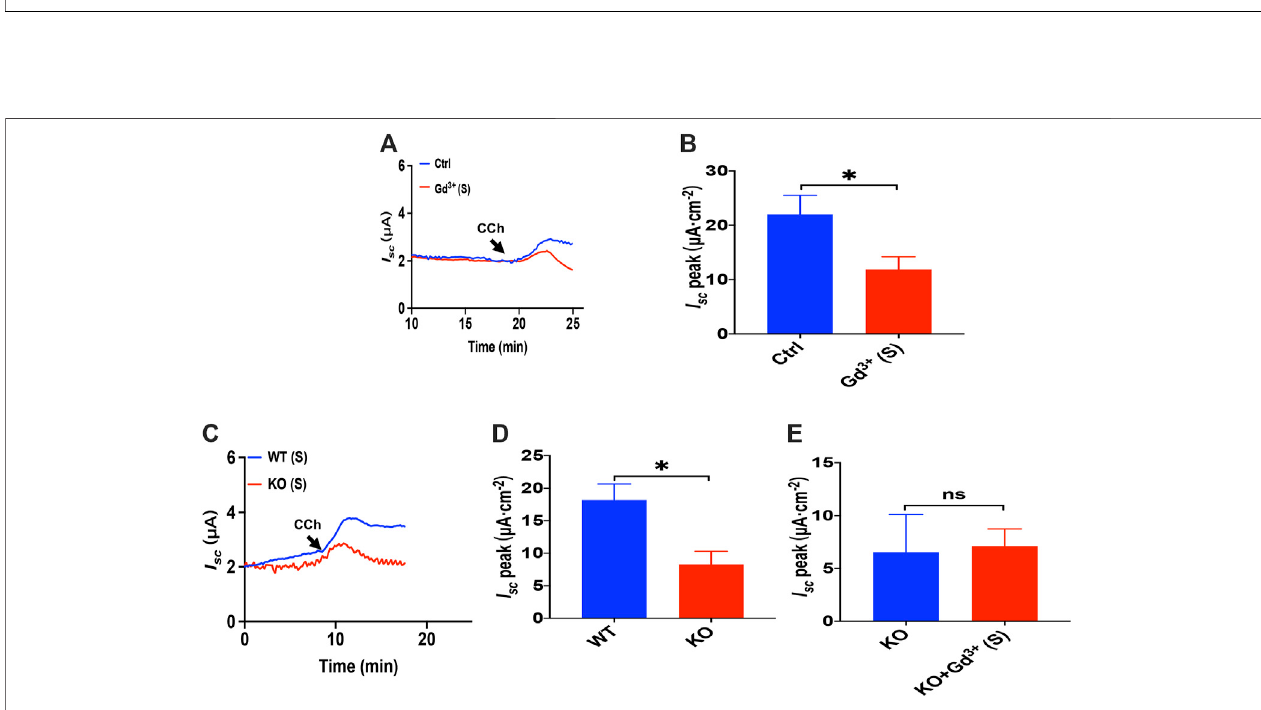
FIGURE 10 | Luminal CCh induced Ca 2+ -dependent duodenal I sc via TRPV4-constituted SOCE. (A,B) luminal CCh(100 μ M)-evoked I sc after GdCl 3 (30 μ M, n (cid:2) 6) added to the serosal (s) side. (C,D) luminal CCh (100 μ M) -evoked I sc in wild-type (W.T.) or TRPV4 K.O. mice ( n (cid:2) 6). (E) luminal-stimulated I sc after GdCl (Gd 3+ , 30 μ M, n (cid:2) 6) was added to the serosal (s) side of TRPV4 KO mice duodenum. Ctrl represents the control without drug treatment. Results are presented as mean ± SE. NS, no signi fi cant differences, * p < 0.05 vs. corresponding control by Student ’ s unpaired, two-tailed t-test.